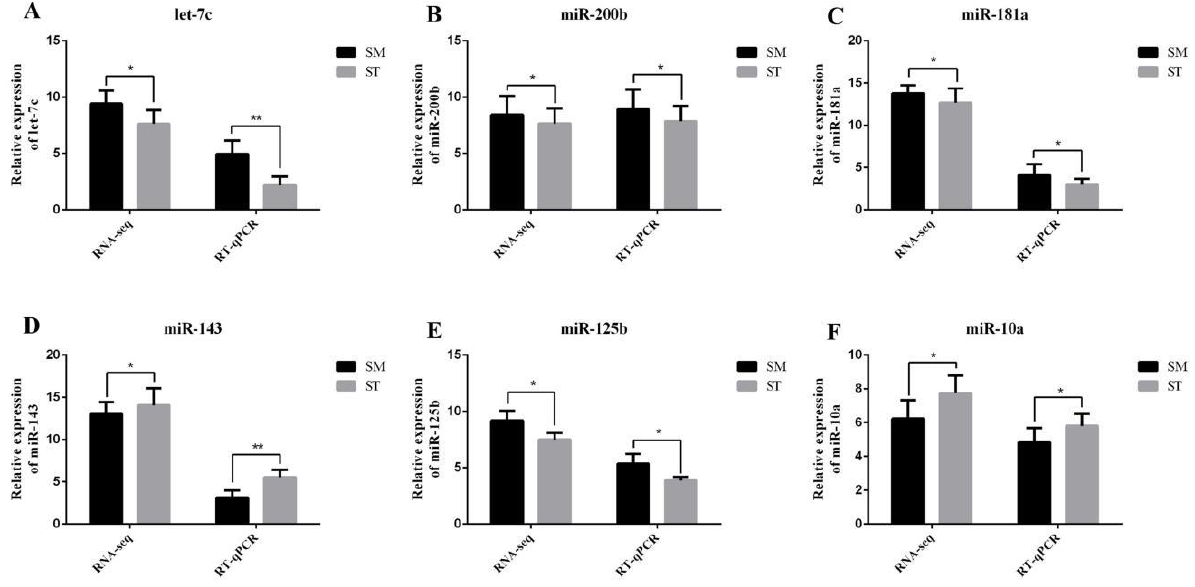
Figure 7. Verification of miRNAs sequencing by RT-qPCR between SM and ST. ( A ) Relative expres- sion of let-7c. ( B ) Relative expression of miR-200b. ( C ) Relative expression of miR-181a. ( D ) Relative expression of miR-143. ( E ) Relative expression of miR-125b. ( F ) Relative expression of miR-10a. * represents statistical significance ( p < 0.05) and ** represents extremely significant difference ( p < 0.01).